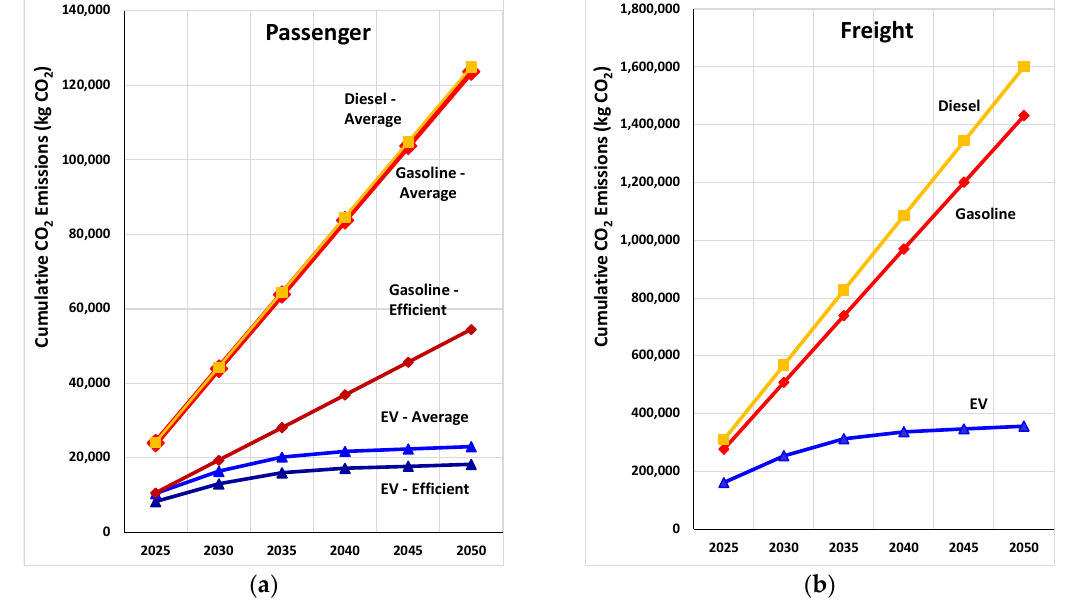
Figure 10. Cumulative vehicle CO 2 emissions from 2020 through 2050 on Oahu in the faster renewable power projection: ( a ) Passenger; ( b ) Freight.